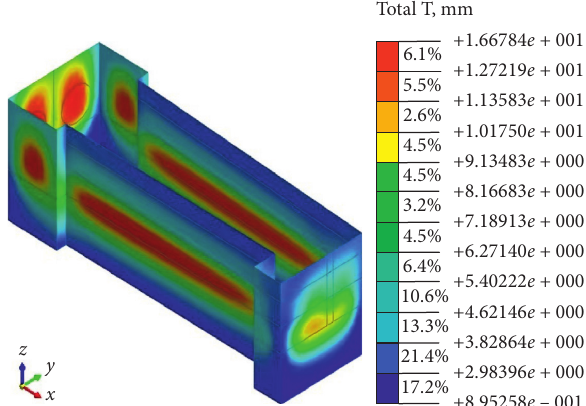
Figure 13: Continuous wall deformation cloud